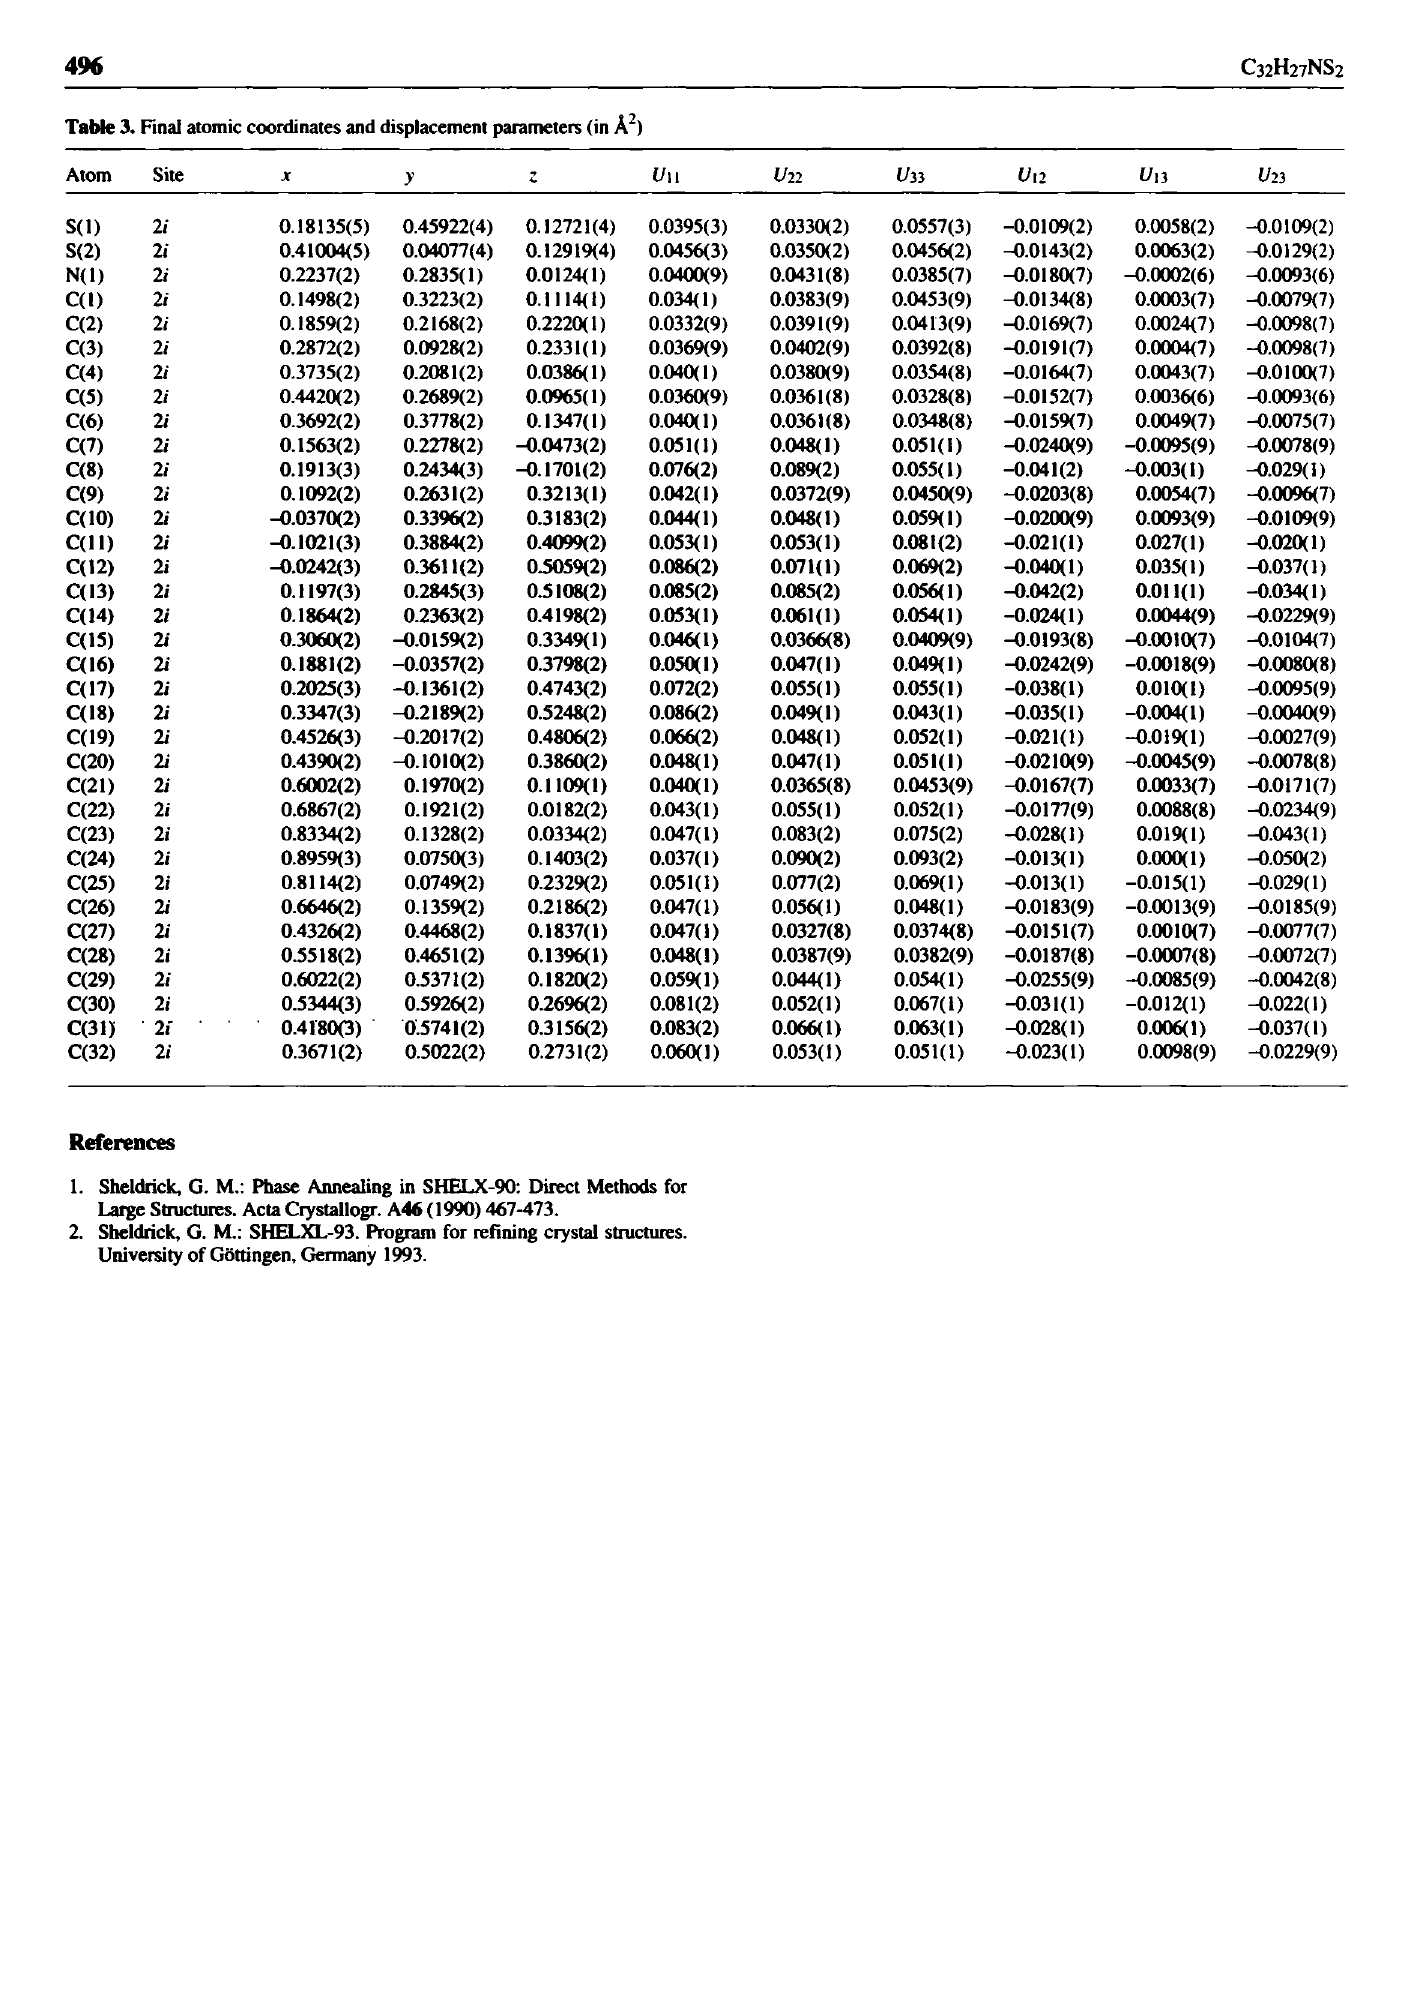
Table 3. Final atomic coordinates and displacement parameters (in Â 2